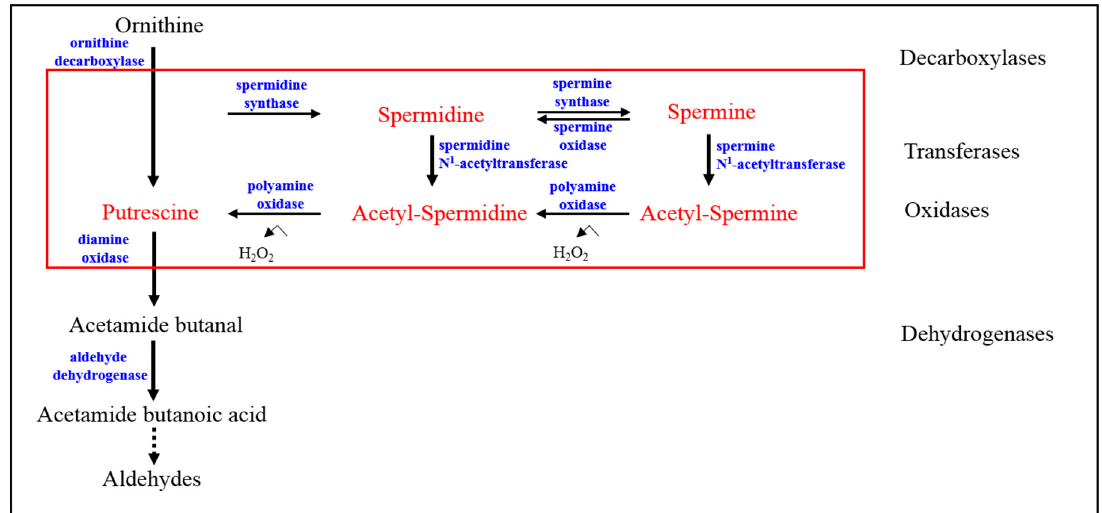
Figure 3. Potential biomarkers in polyamine metabolism.